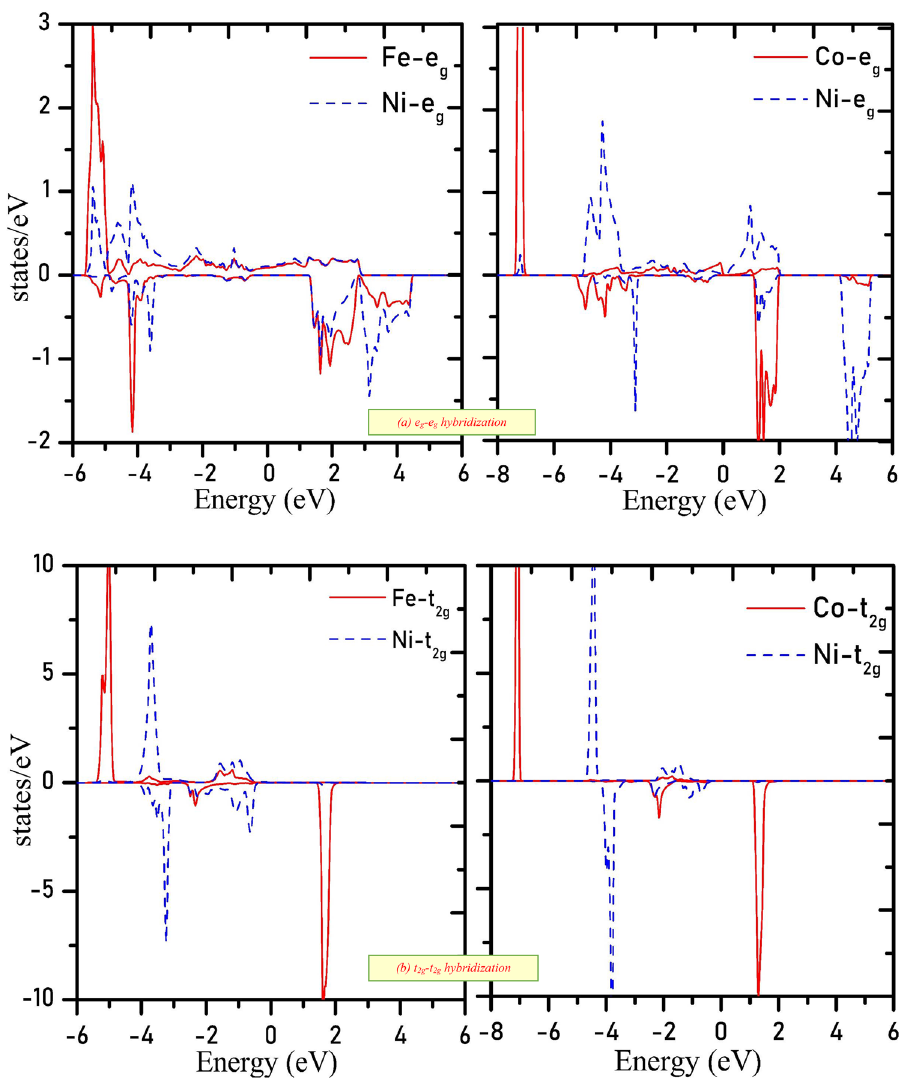
Figure 4. t 2g and e g - states distribution ( a ) Overlapping of e g -e g states signify e g -states are hybridized; ( b ) t 2g -t 2g hybridize feebly. Sharp peaks at certain energy value designate the presence of large degenerate energy states at that particular energy value.